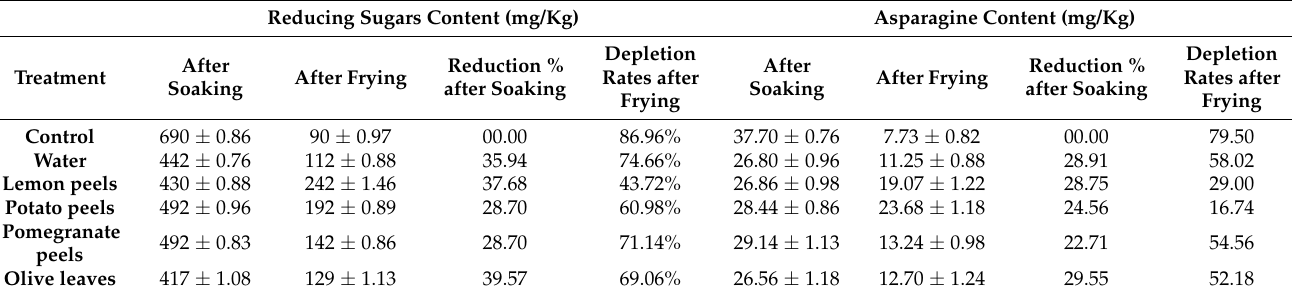
Table 3. Changes in reducing sugar and asparagine contents in potato slices during soaking and frying of potato